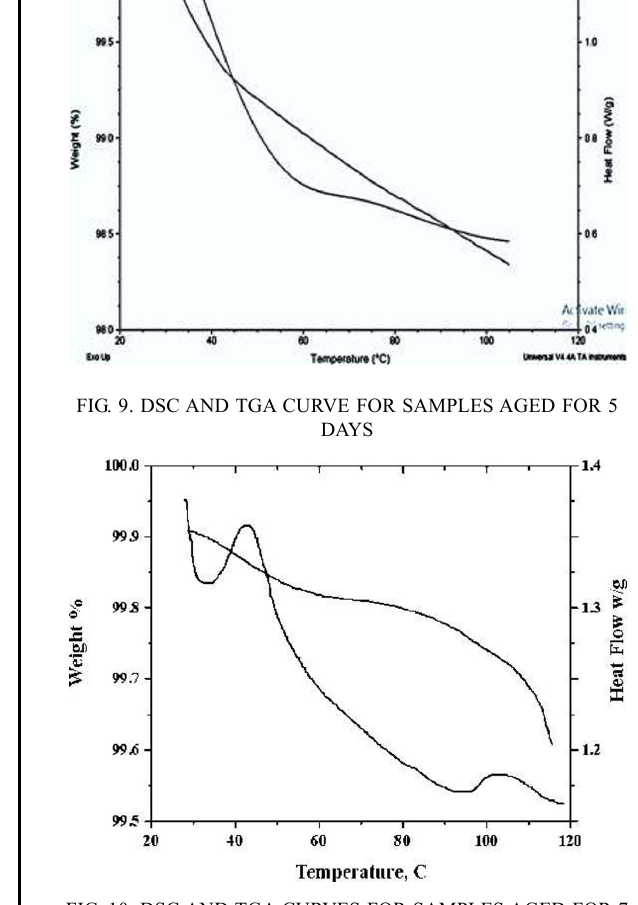
FIG. 10. DSC AND TGA CURVES FOR SAMPLES AGED FOR 7 TABLE 4. TENSILE RESULTS OF STRESS, STRAIN, YIELD STRENGTH AND LOAD OF MULTI STRESS AGEING